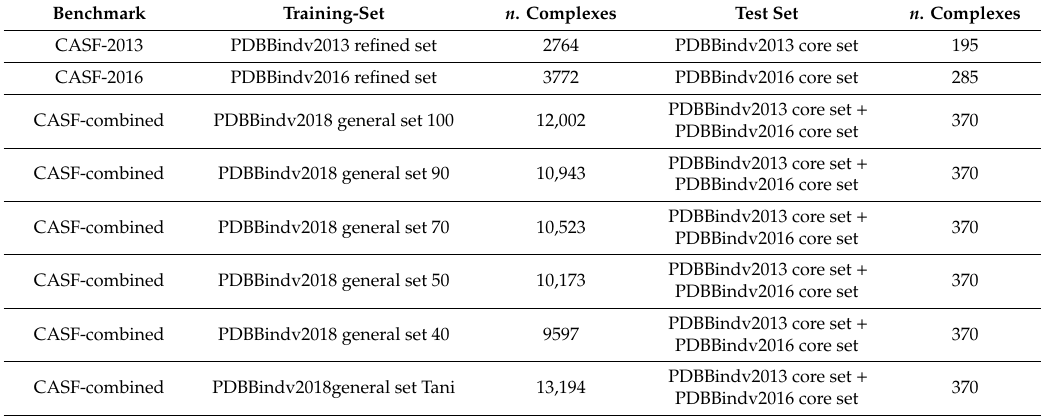
Table 1. Summary table of the training and test sets used. CASF-combined refers to a set obtained from the union of the complexes in CASF-2013 and CASF-2016. The trailing number of the training sets refers to the identity percentage used for filtering out similar complexes between the test and training set, whereas the -Tani su ffi x refers to the set where complexes were removed via the Tanimoto coe ffi cient, as described